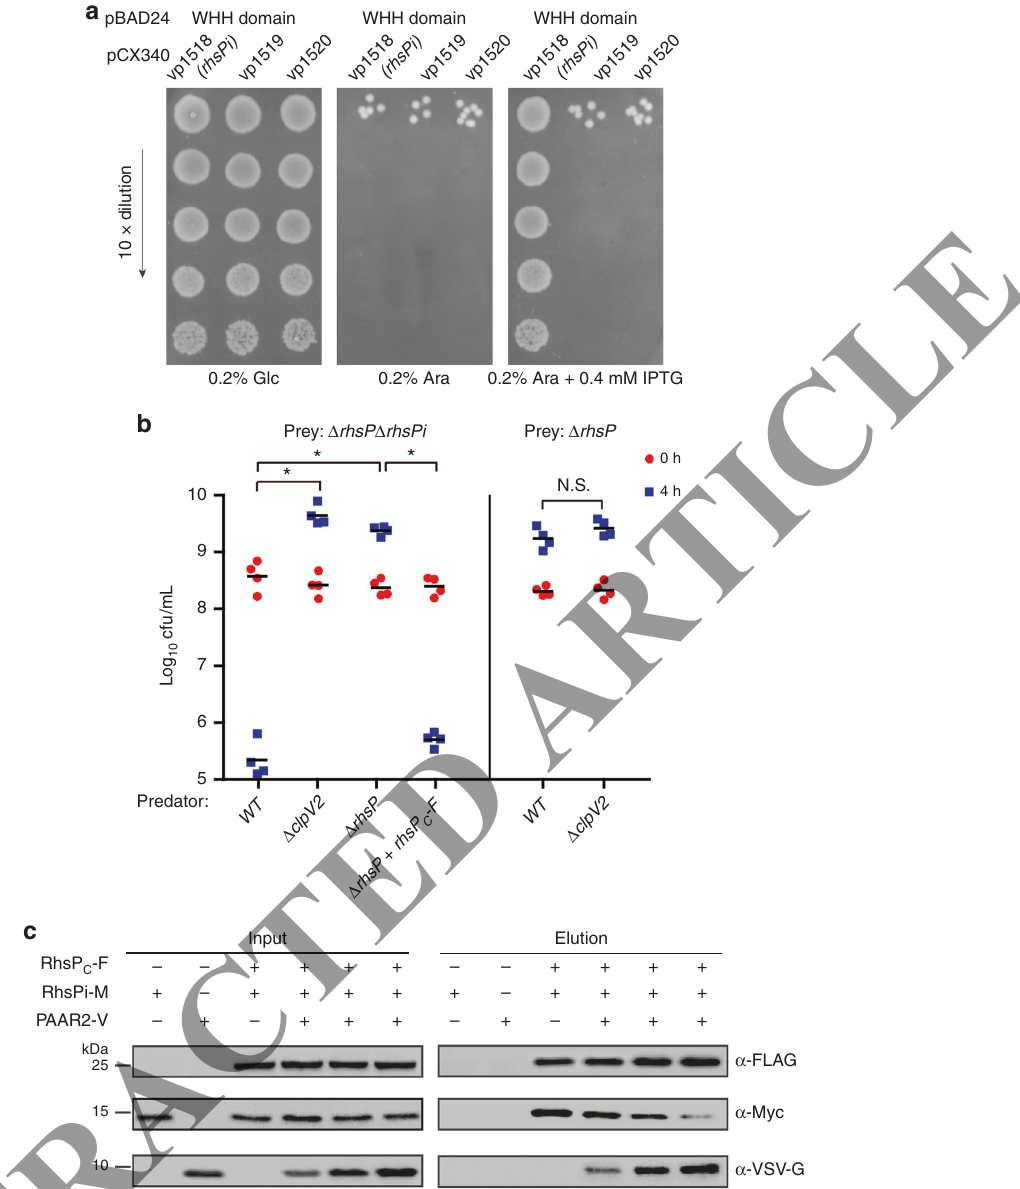
Fig. 4 RhsPi (VP1518) is the immunity protein to RhsP. a RhsPi from V. parahaemolyticus RIMD2210633, not VP1519 or VP1520, neutralized the toxicity of WHH domain in E. coli DH5 α . WHH domain was expressed under the control of arabinose and other tested genes were expressed under the control of IPTG in E. coli DH5 α . b Killing assays between various strains of V. parahaemolyticus . Prey cells contain a pBBR332 plasmid (kanamycin resistance) for selection purpose. The means of each data set in one representative experiment performed with quadruplicates were shown. Equivalent results were obtained at least three times. Asterisks mark statistical signi fi cance of bacterial CFU between sample groups at t = 4 h ( P < 0.05) by the two-tailed Student t test. N.S., no signi fi cant difference ( P > 0.01). c RhsPi binds to RhsP C . Myc epitope-tagged RhsPi (RhsPi-M) was immuno-precipitated by FLAG-tagged